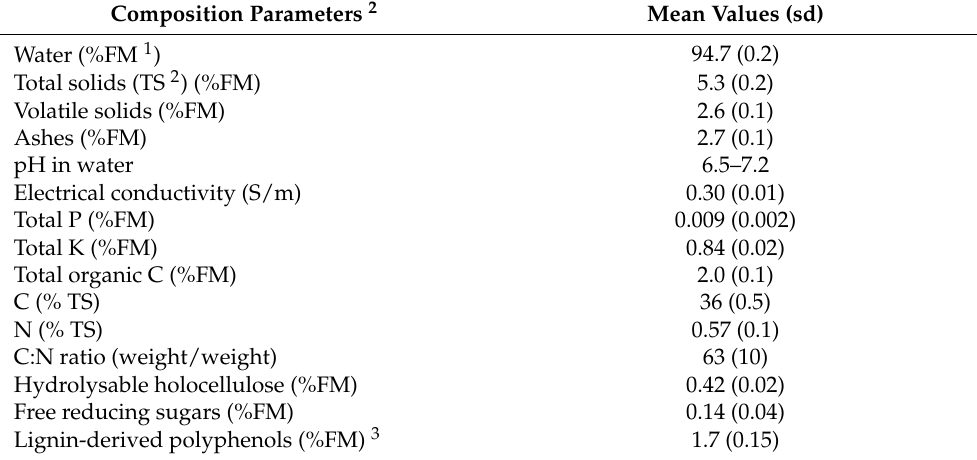
Table 3. Characterization of the giant reed extract obtained by treating a slurry of dry meal (10% weight/weight in water) with alkali (KOH 1.6% weight/weight in water) at 120 ◦ C for 20 min after filtering and neutralization with H 2 SO 4 . The standard deviation (sd) of the mean is reported in brackets ( n = 3